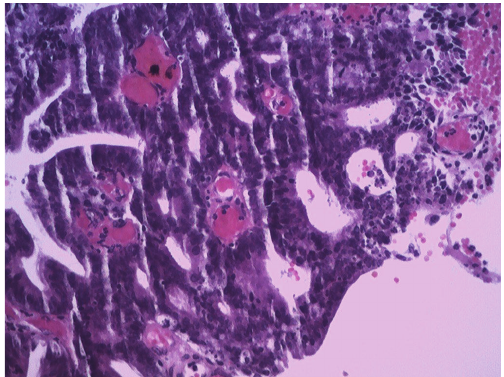
Figure 2: Invasive moderately differentiated mucinous adenocarci- noma endocervical type composed of irregular and anastomosing glands with cribriform arrangements.